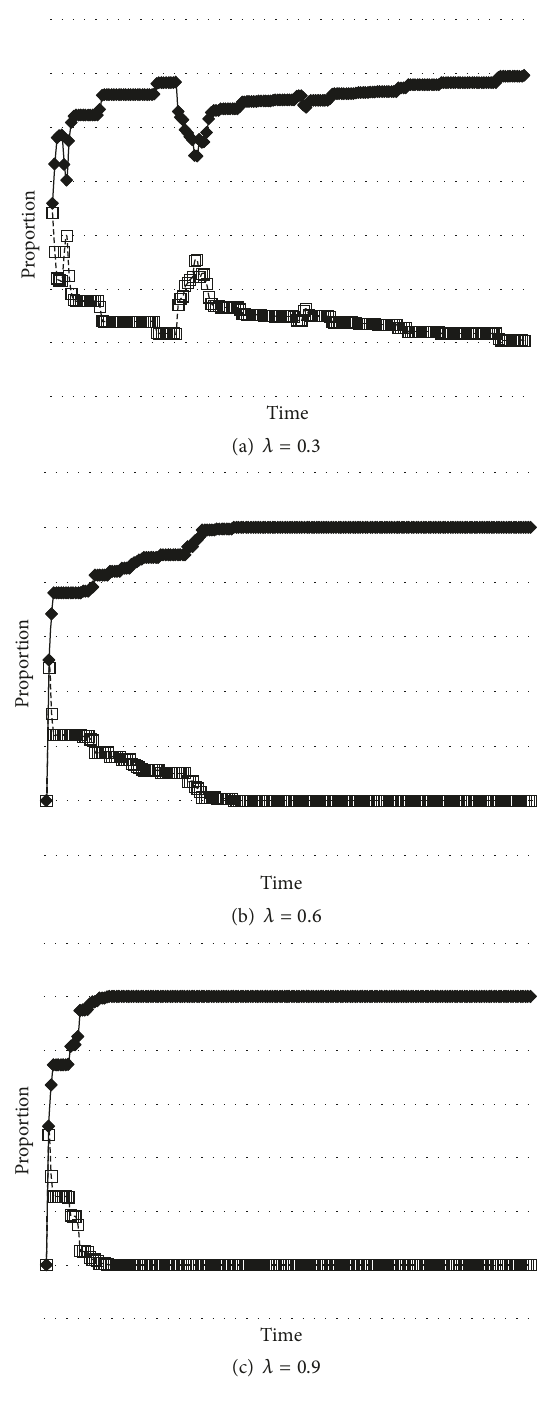
Figure3:Theevolutionarytrendoftheproducers’strategyselection in model I.